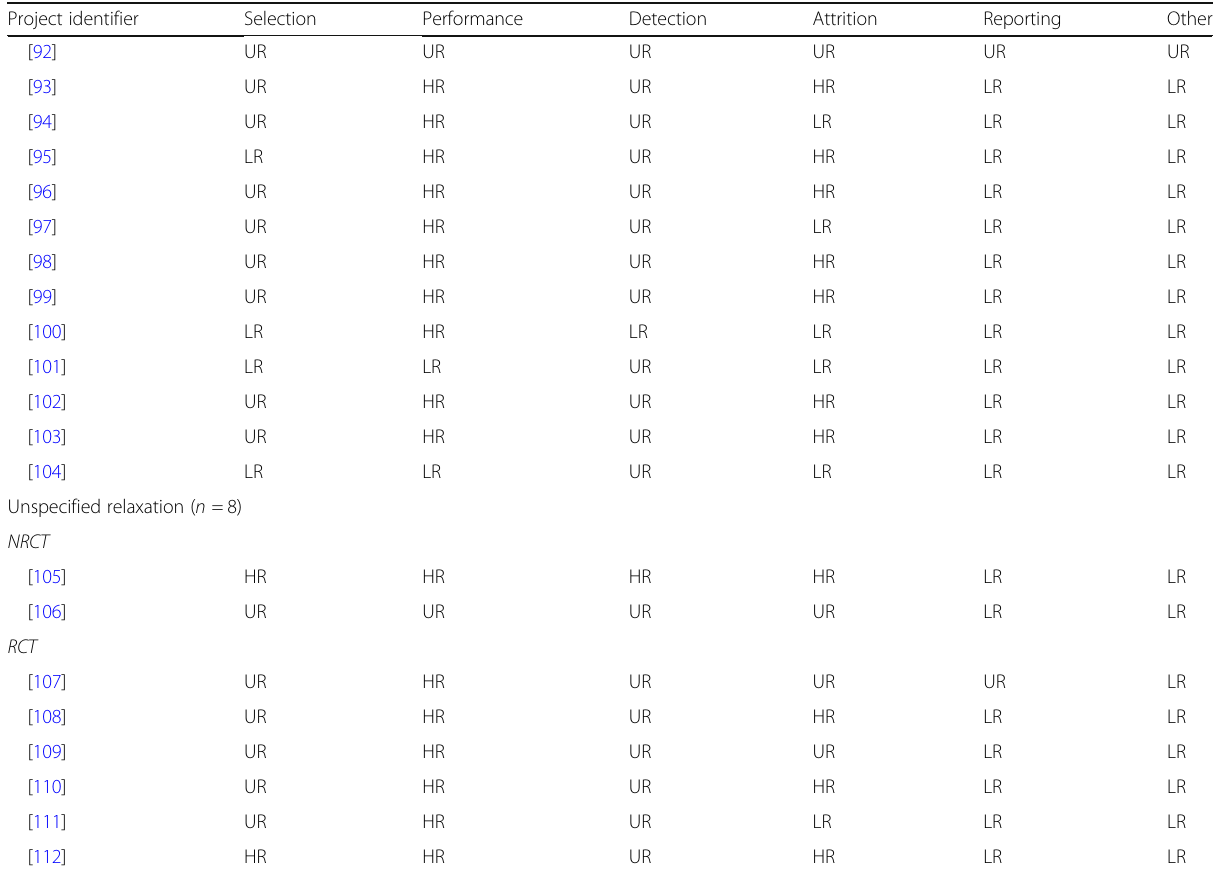
Table 3 Risk of bias of included studies (Quantitative approaches)